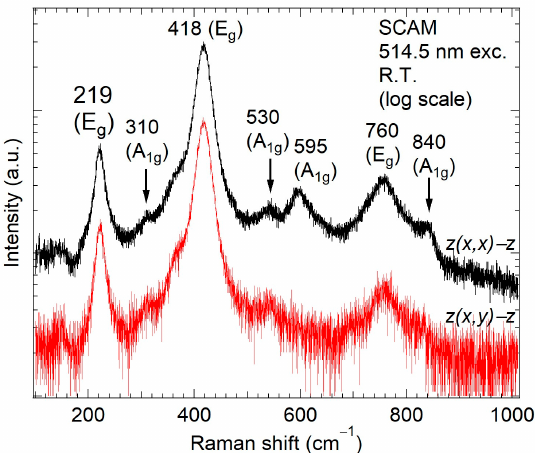
Figure 7. Raman spectra of SCAM by back-scattering from the c -plane with parallel (upper) and crossed (lower) polarizations plotted in logarithmic scale.